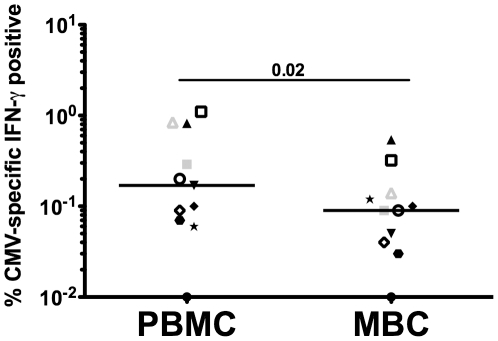
Reduced frequency of CMV-specific T cells derived from the menstrual blood.PBMC and MBC from the same women were stimulated with overlapping peptides from CMV pp65 or CMV lysate and stained for IFN-γ. Individual symbols represent paired samples from the same individual. Open symbols represent CD8 T cell responses, closed symbols represent CD4 T cell responses and gray symbols are responses from the healthy volunteer. Statistical comparisons were made using Wilcoxon Signed Rank test.